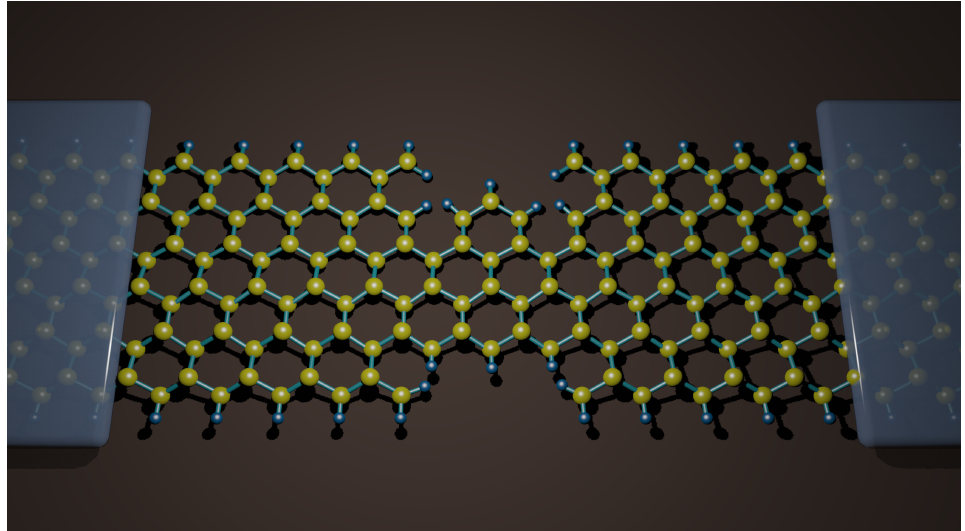
Figure 10. Schematic of the device with two semi-infinite electrodes and the zigzag trigonal nanodisc (N = 2) as the central part, connected to the screening region of the graphene and silicene nanoribbons. Yellow balls represent C or Si atoms for graphene or silicene case, respectively, whereas blue balls represent H atoms.